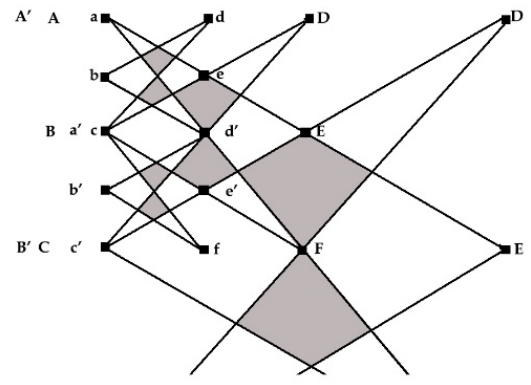
Figure 5. Scalable scales of cliques and cognitive communities.